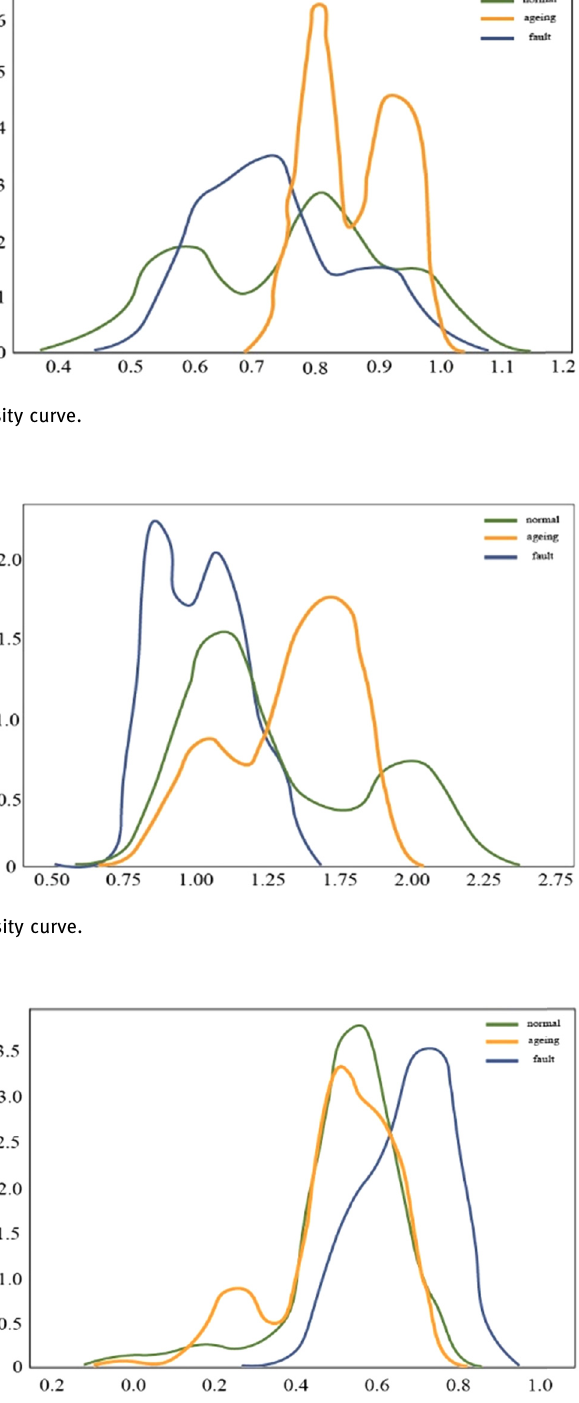
Figure 6: MPC probability density curve